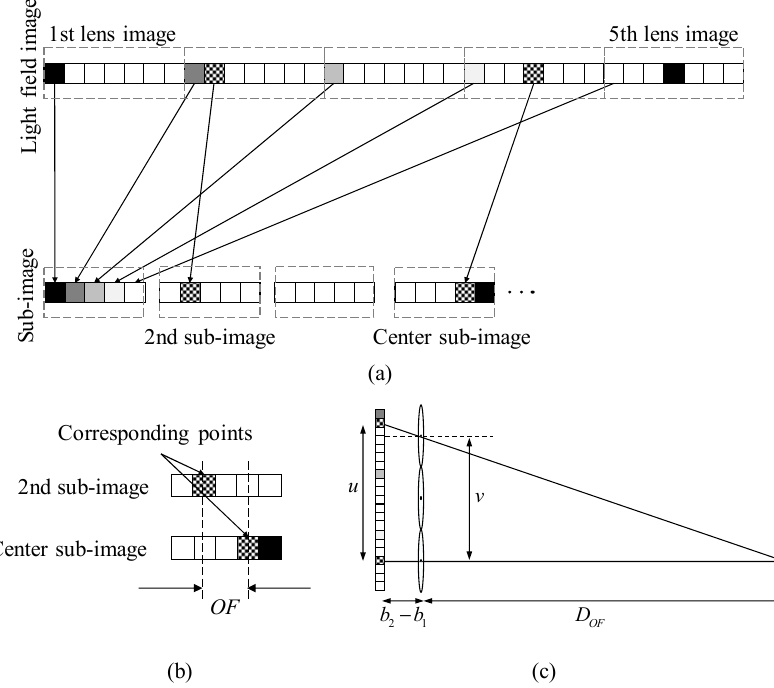
Figure A1. ( a ) Sub-image extraction from light field image; ( b ) optical flow calculation between corresponding points; and ( c ) schematic diagram to derive Equation (1). OF: optical flow.